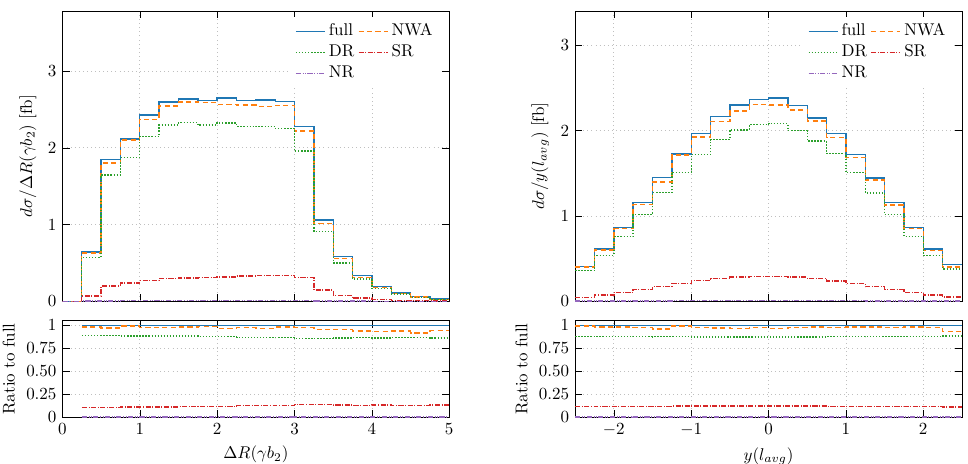
Figure 8 . The pp e + (cid:23) e (cid:22) (cid:0) (cid:22) (cid:23) (cid:22) b (cid:22) b(cid:13) di(cid:11)erential cross section distribution as a function of the ! rapidity-azimuthal angle separation between the hard photon and the softest b -jet and the (aver- aged) rapidity of the charged lepton at the LHC run II with p s = 13 TeV. The upper plots show absolute NLO QCD predictions for DR, SR and NR regions. Also shown are NLO results for full o(cid:11)-shell and NWA case. The ratios of these contributions to the full o(cid:11)-shell result are also shown. Results are given for (cid:22) 0 = H T = 4 and the CT14 PDF